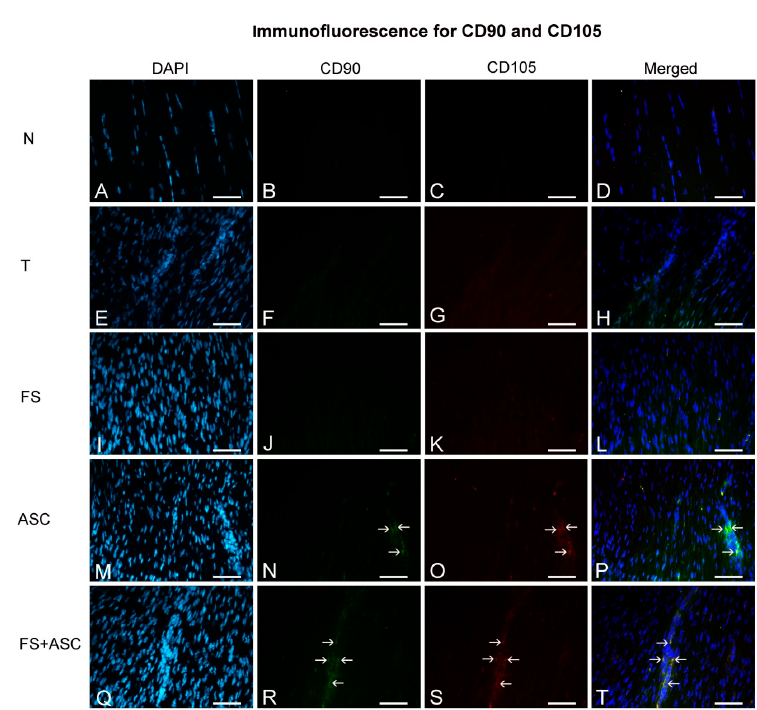
Figure 4. Immunofluorescence for CD90 and CD105 observed in the central portion of the TR of tendons on the 21st day ( n = 5). Groups N ( A – D ), T ( E – H ), FS ( I – L ), ASC ( M – P ) and FS + ASC ( Q – T ). Note CD90 and CD105 ( → ) positive marking in the transected region of ASC and FS + ASC groups. Bar = 50 µ m.